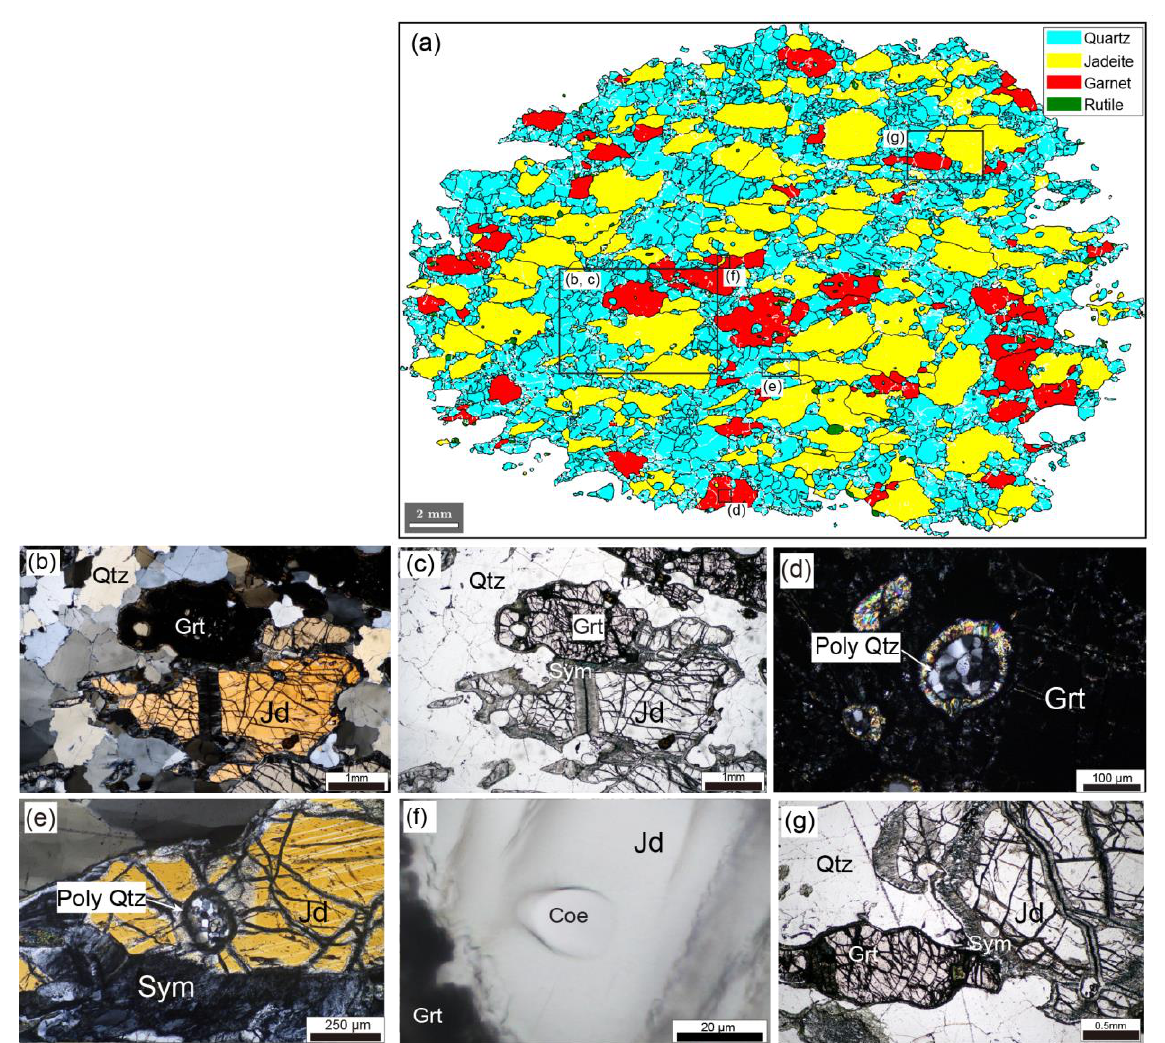
Figure 5. Microstructures of jadeite quartzite. ( a ) EBSD phase map of entire thin-section. White areas in the map are non-indexed pixels. Black rectangles indicate areas shown in ( b – g ). ( b , c ) Photomicrographs of jadeite quartzite under cross- polarized light (left) and plane-polarized light (right). ( d ) Photomicrograph of polycrystalline quartz in garnet under cross- polarized light. ( e ) Photomicrograph of polycrystalline quartz in jadeite under cross-polarized light. ( f ) Photomicrograph of coesite inclusion in jadeite under cross-polarized light. ( g ) Photomicrograph of jadeite quartzite with symplectite under plane-polarized light. Qtz, quartz; Jd, jadeite; Grt, garnet; Sym, symplectite; Poly Qtz, polycrystalline quartz; Coe, coesite.